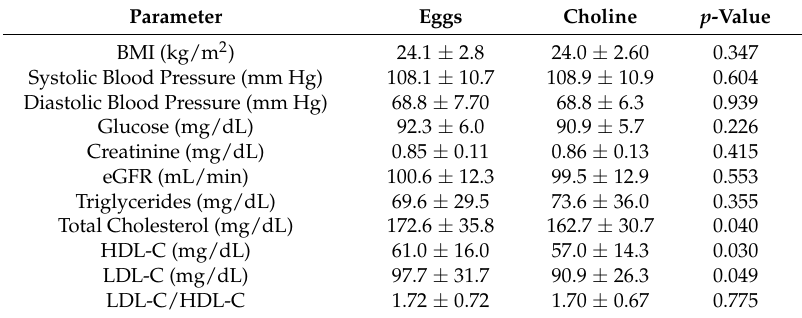
Table 4. Anthropometrics measures and fasting plasma biochemical parameters of subjects ( n = 29) at the end of each intervention arm, three eggs versus choline bitartrate supplement intake for 4 weeks each.